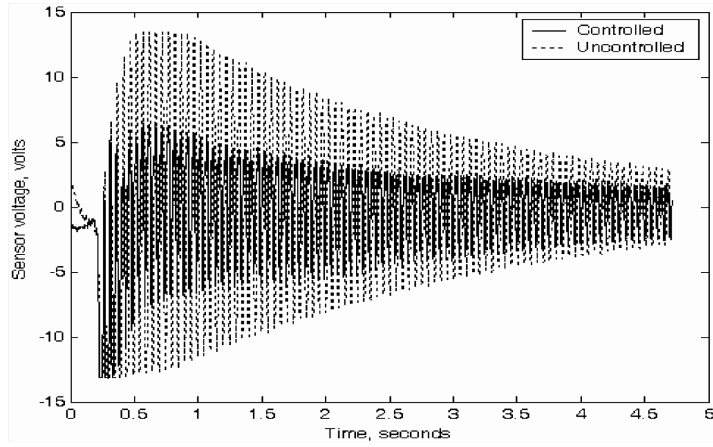
Fig. 14. Fuzzy logic based SMC of plate.